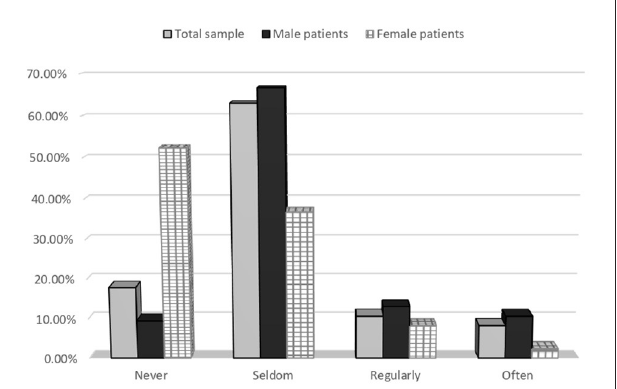
FIGURE2 Discussing sexuality with patients with neurological disease, total results, and results in subgroups according to age group.